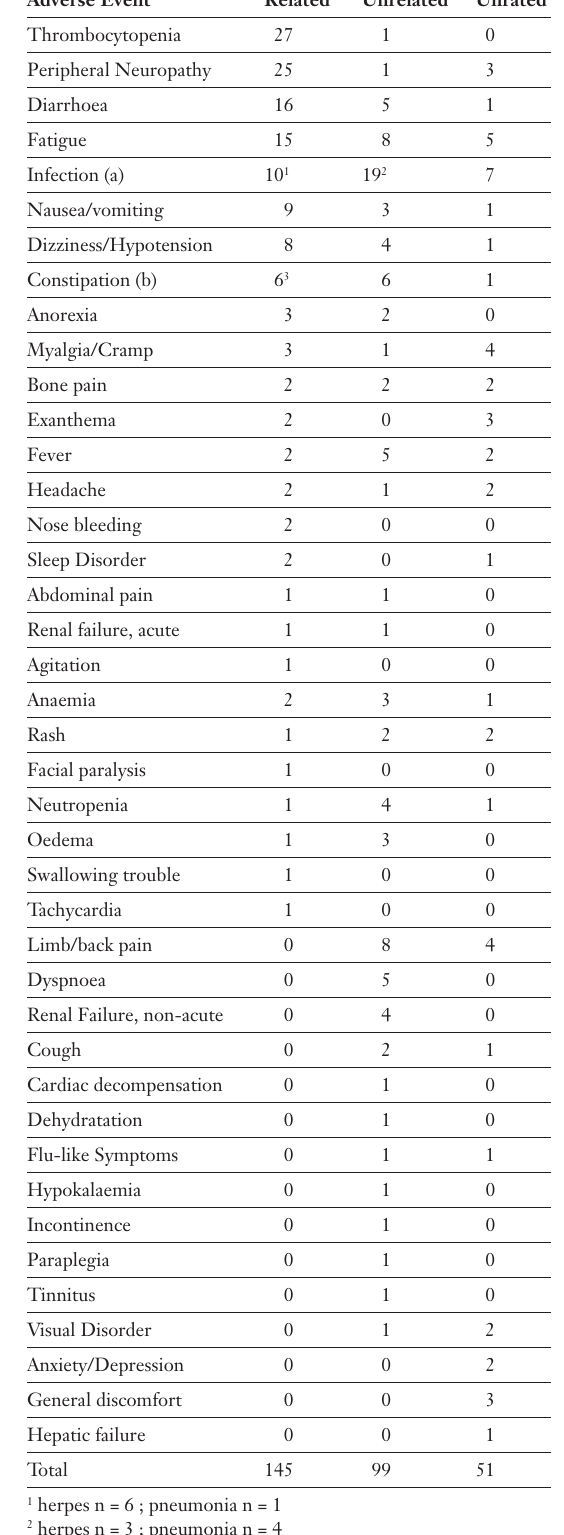
Table 4 Documented adverse events (AEs). Related AEs were those rated by the physician as probably or possibly related to bortezomib treatment. AEs shaded in blue are those having occurred in ≥ 10% of patients (see text for